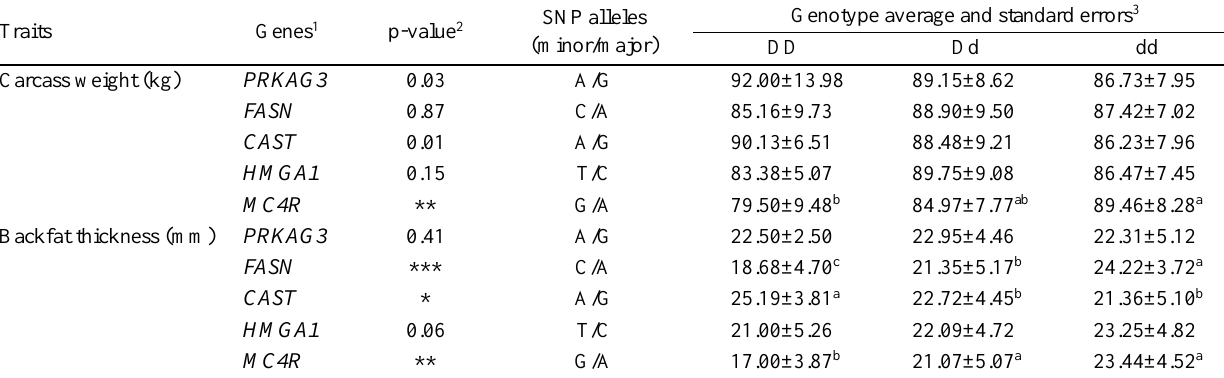
Table 3. Association of SNP genotypes and their harboring genes with carcass traits in Duroc breeding stock Traits